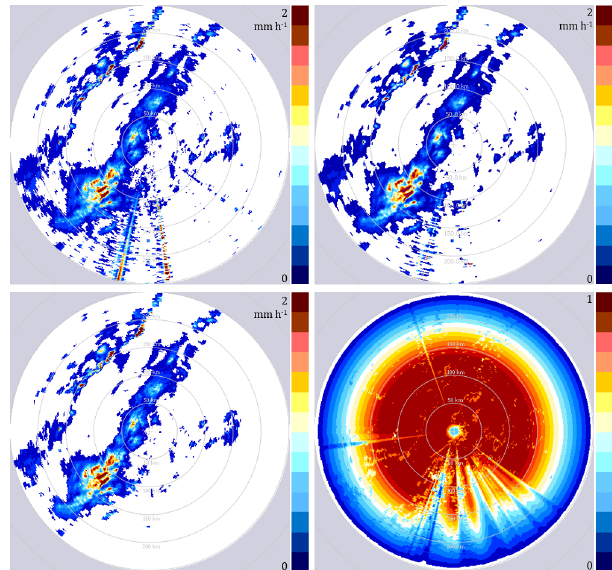
Figure 12. Example of RADVOL-QC algorithm performance. From the top left: raw data, data after corrections made with ver- sion from 2014; from the bottom left: data after corrections made with current version (2021), and related quality index field. Ram˙za radar, SRI product, 2 October 2019, 12:10UTC, range of